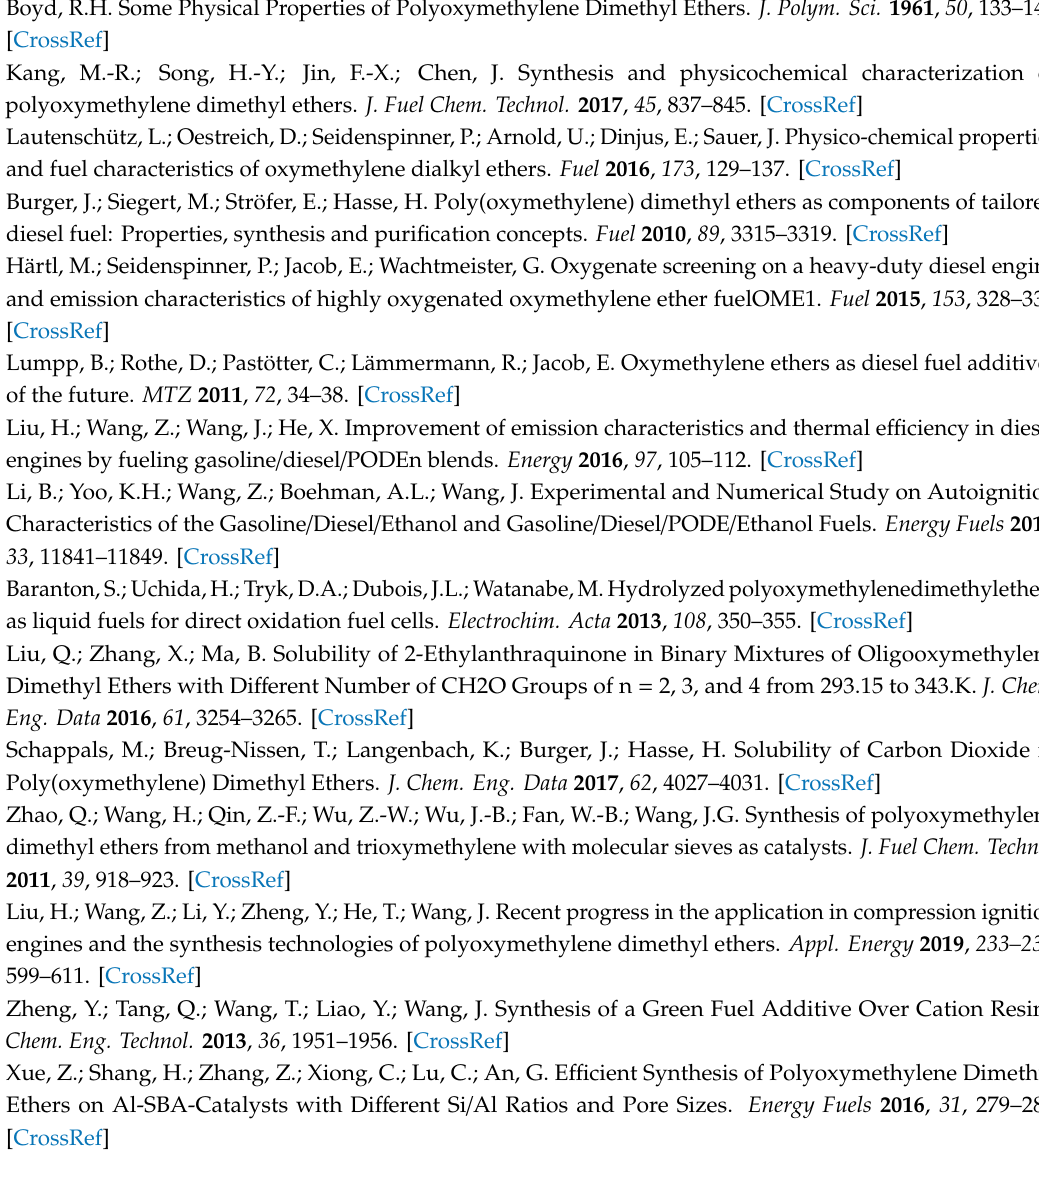
Table S1: Experiment data of H2O (1) + PODE2 (2).(p = 101.3kPa), Table S2: UNIFAC structural groups with size and surface parameters, Table S3: UNIFAC group assignment, Table S4: The UNIFAC group interaction parameters, Table S5: Raw material composition and chemical properties of the materials, Table S6: Experimental results of batch